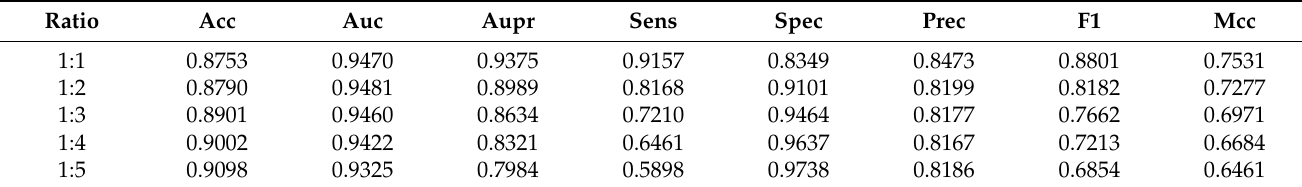
Table 2. Performance comparison of different ratio of positive and negative